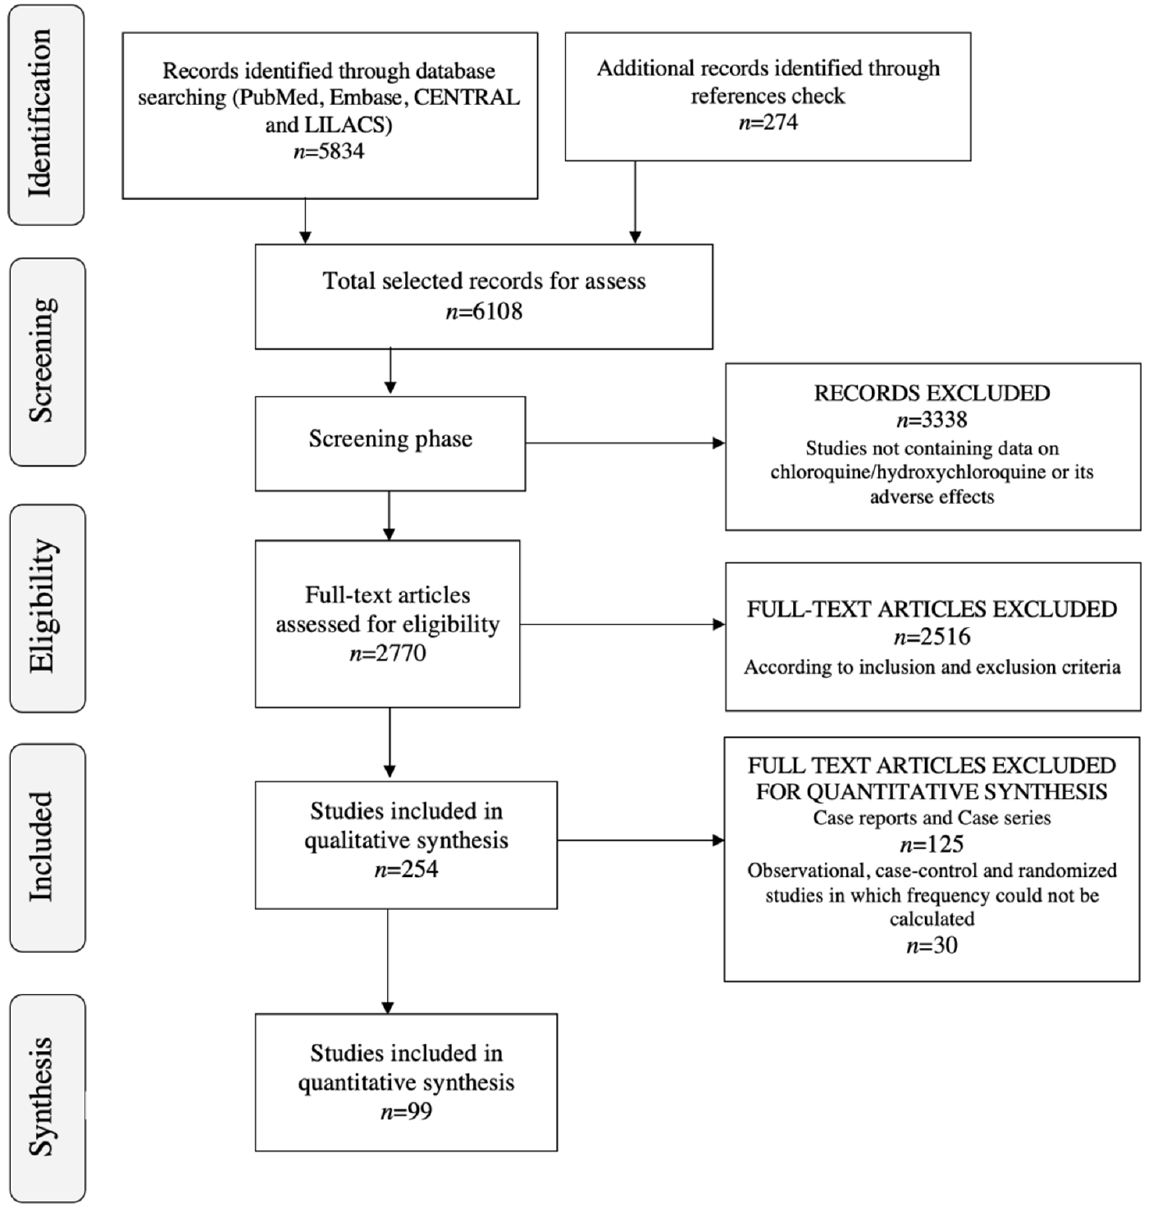
Figure 1. Safety of chloroquine and hydroxychloroquine. Selection process, flow diagram.